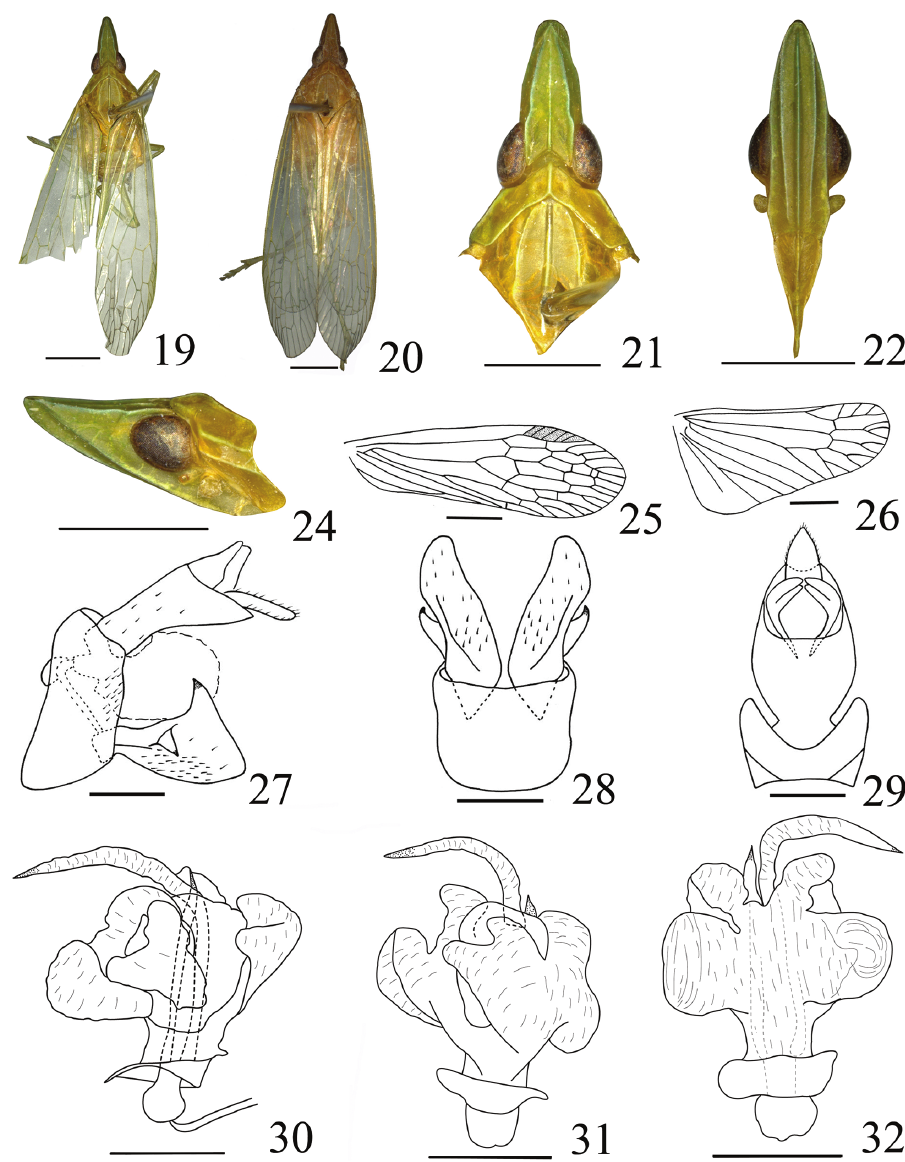
lateral view 22 Head and thorax, dorsal view 23 Frons and clypeus, ventral view 24 Head and pronotum, lateral view 25 Forewing 26 Hind wing 27 Pygofer and anal tube, dorsal view 28 Pygofer and parameres, ventral view 29 Genitalia, lateral view 30 Aedeagus, lateral view 31 Aedeagus, ventral view 32 Aedeagus, dorsal view. Scale bars 19–26 = 2 mm; 27–32